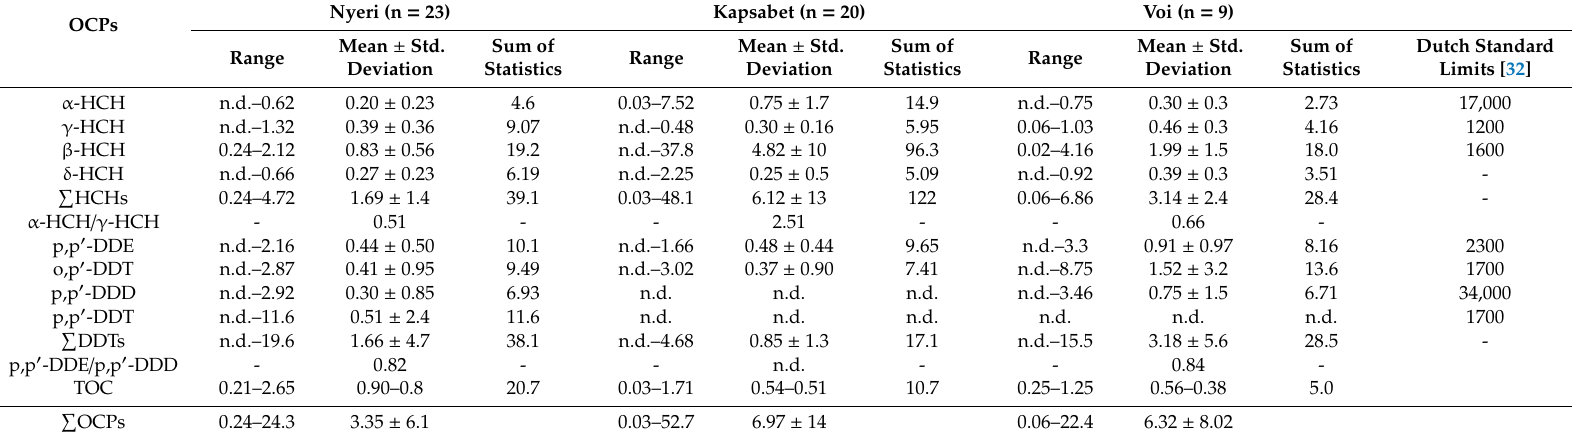
Table 2. The concentrations of HCHs, DDTs (ng / g), and TOC (%) in suburban soils from Nyeri, Kapsabet, and Voi. OCPs were reported in all the sampled locations.